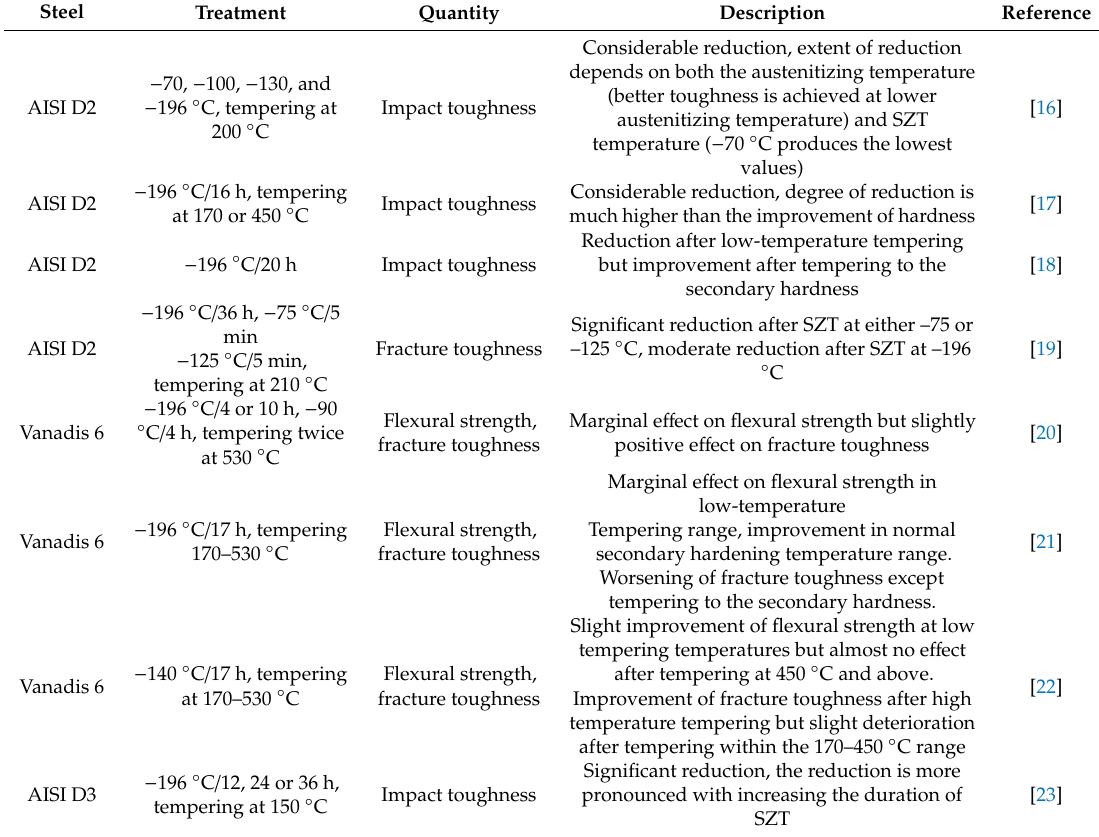
Table 1. Toughness and fracture toughness of di ff erently sub-zero treated ledeburitic steels—an overview of the obtained results to